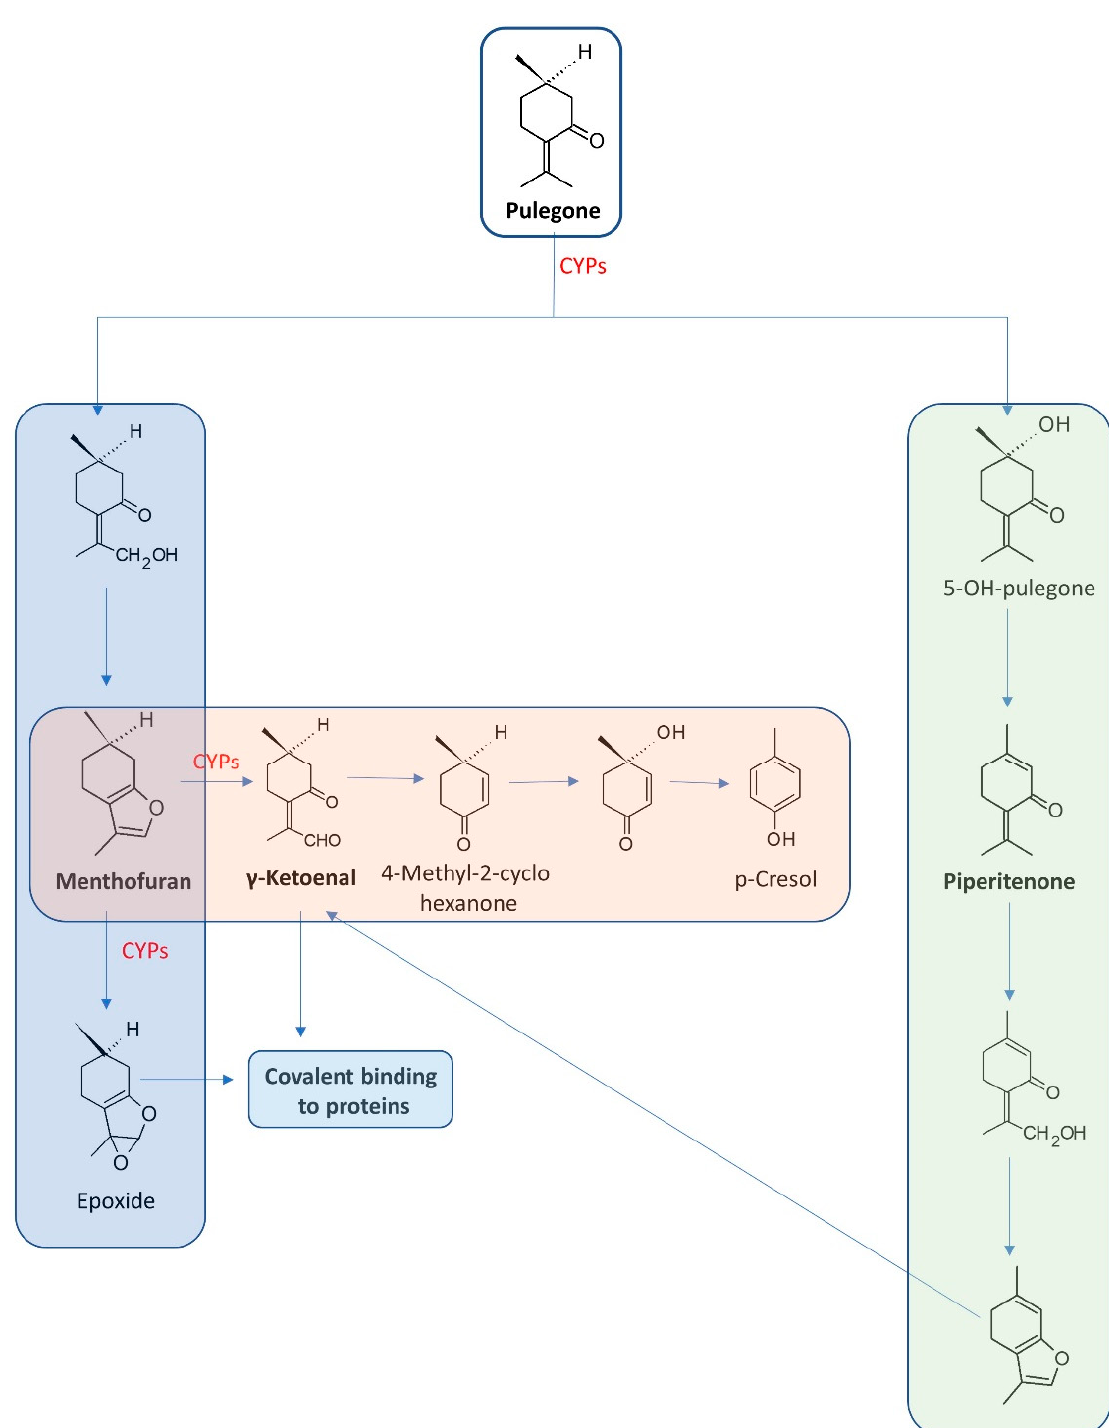
Figure 3. Metabolism of pulegone. The most important metabolites are emboldened.